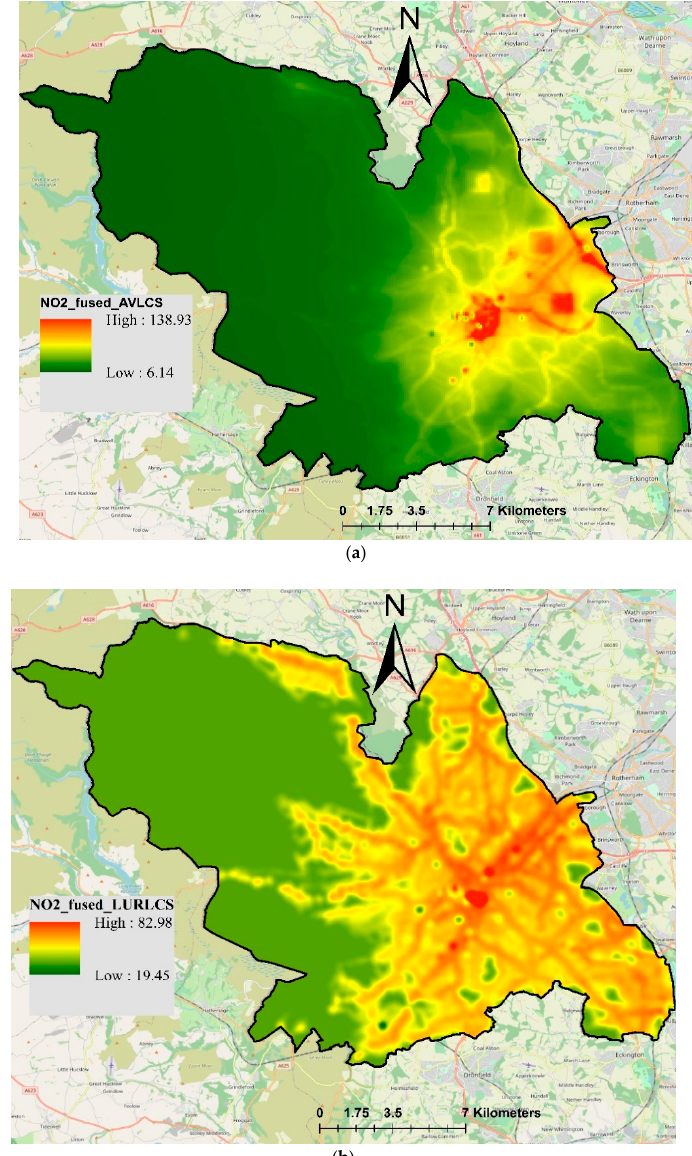
Figure 7. Resulting map of fused NO 2 concentrations (µg/m 3 ) using universal kriging techniques: ( a ) NO 2 Airviro-LCS; ( b ) NO 2 LUR-LCS. 3.2.2. Fusion of NO 2 -DT with NO 2 -Airviro and NO 2 -LUR Maps produced by the fusion of NO 2 -DT with NO 2 -Airviro and NO 2 -LUR are presented in Figure 8, where the fusion of Airviro-DT is shown in Figure 8a and the fusion of LUR-DT is shown Figure 8b. The fused NO 2 Airviro-DT ranged from 17.19 to 74.78 µg/m 3 . NO 2 -Airviro concentrations ranged from 0.69 to 110, whereas NO2-DT ranged from 13.58 to 91.75 µg/m 3 . Airviro-DT showed higher concentrations in the city centre, east and northeast part of the city and relatively lower con- centrations in the outskirts of the city, especially towards the west and northwest part of the city. Figure 8b shows NO 2 LUR-DT, which is the fusion between NO 2 -LUR and NO 2 -DT. Here, higher NO 2 LUR-DT are shown in the city centre, eastern and northeastern parts. However, some busy roads and hotspots are also highlighted in some other parts of the city. NO 2 LUR-DT ranged from 4.13 to 64.49 µg/m 3 . Statistical metrics used to compare measured concentrations with fused concentrations (Table 2) showed the same correlation coefficient for both LUR-DT and Airviro-DT (r, 0.70). The values of other metrics, e.g., RMSE and MAE, also demonstrated negligible differences. However, visually, LUR-DT produced more detailed maps and successfully highlighted higher pollution levels on sev- eral busy roads.